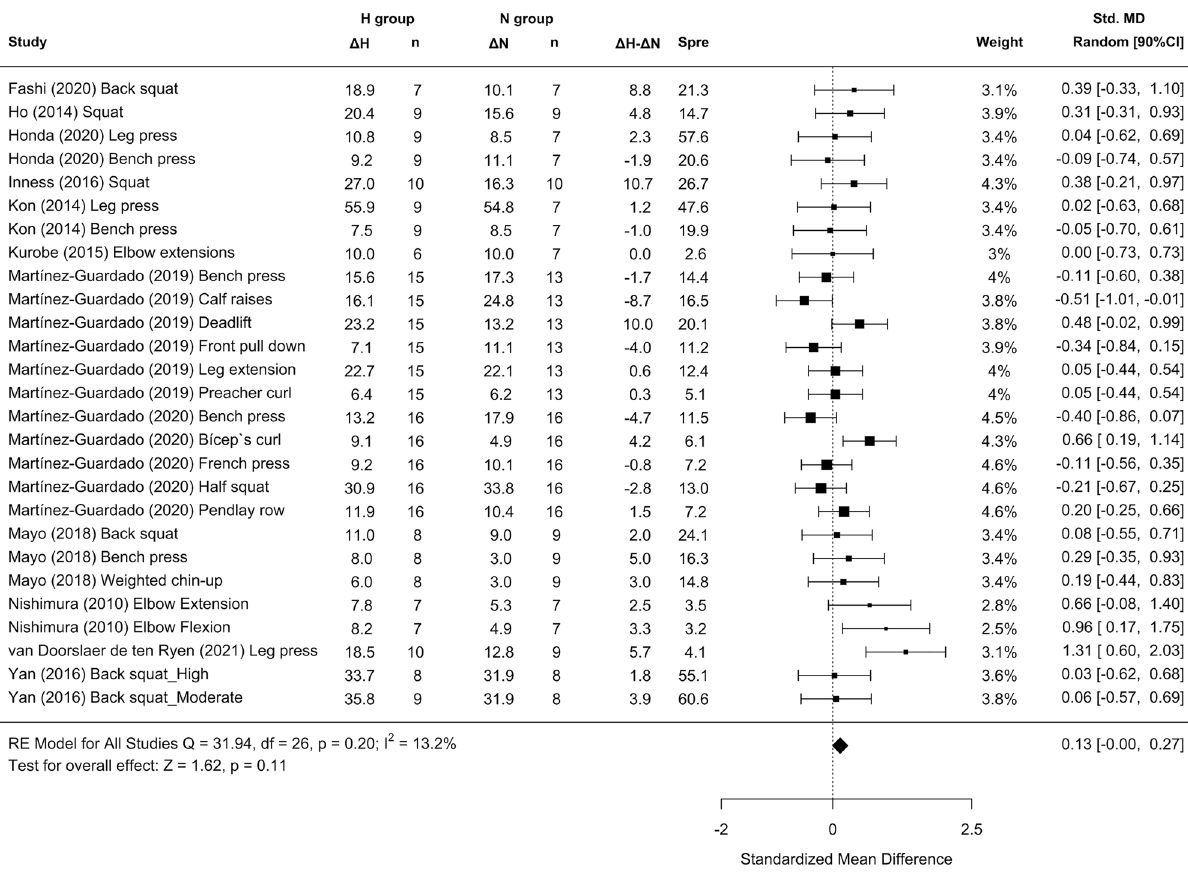
Figure 7. Forest plot of the standardized mean differences of the total effect of the resistance training program between-conditions (hypoxic [H] group vs. normoxic [N] group) on RM. Δ: mean differences between post–pre in H and N or between H–N; n: sample size; Spre: mean baseline standard deviation; Std. MD: standard mean difference; RE: random effect’s model; CI; confidence interval; Q: test statistic for the test of heterogeneity; df: degrees of freedom; p : p value; I 2 : I 2 test; Z: z value. Yan et al. 44 study provides a group with moderate hypoxia and another with high